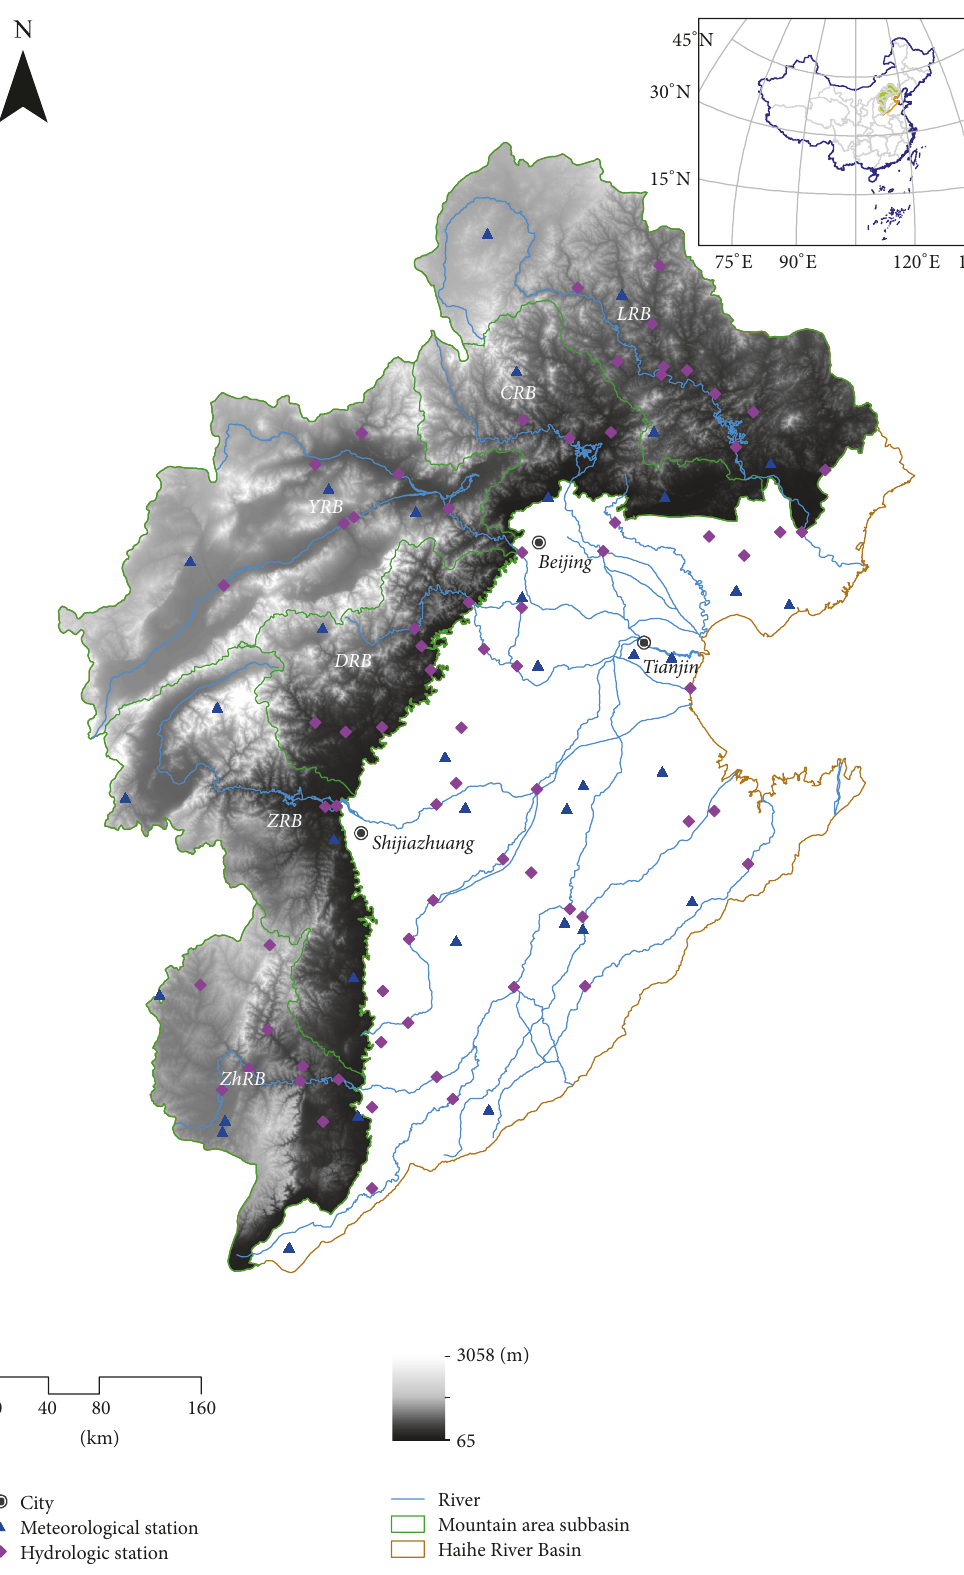
Figure 1: Haihe River Basin (HRB) and the subbasins in the mountainous region of the basin. Luan River Basin (LRB) and Chaobai River Basin (CRB) are located in the north; Yongding River Basin (YRB) and Daqing River Basin (DRB) are located in the center; Ziya River Basin (ZRB) and Zhang River Basin (ZhRB) are located in the